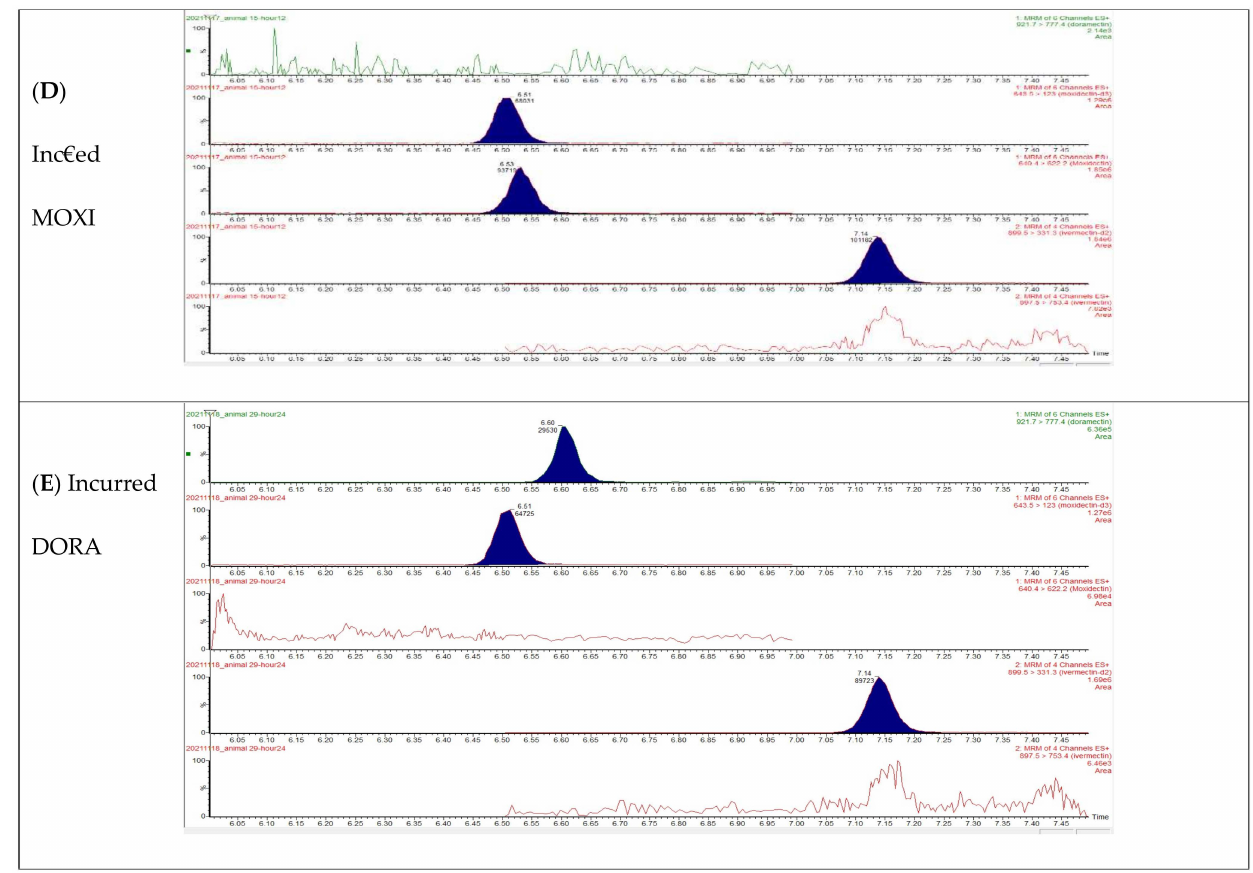
Figure 2. UHPLC-MS/MS chromatogram of ( A ) a blank plasma, ( B ) a quality control (QC) sample spiked with all analytes at a concentration of 50 ng/mL and incurred plasma samples containing ( C ) IVER (concentration: 128.89 ng/mL), ( D ) MOXI (concentration: 99.84 ng/mL), and ( E ) DORA (concentration: 14.60 ng/mL) that were extracted using 1% formic acid in acetonitrile as deproteiniza- tion solvent, followed by OstroTM 96-well plate